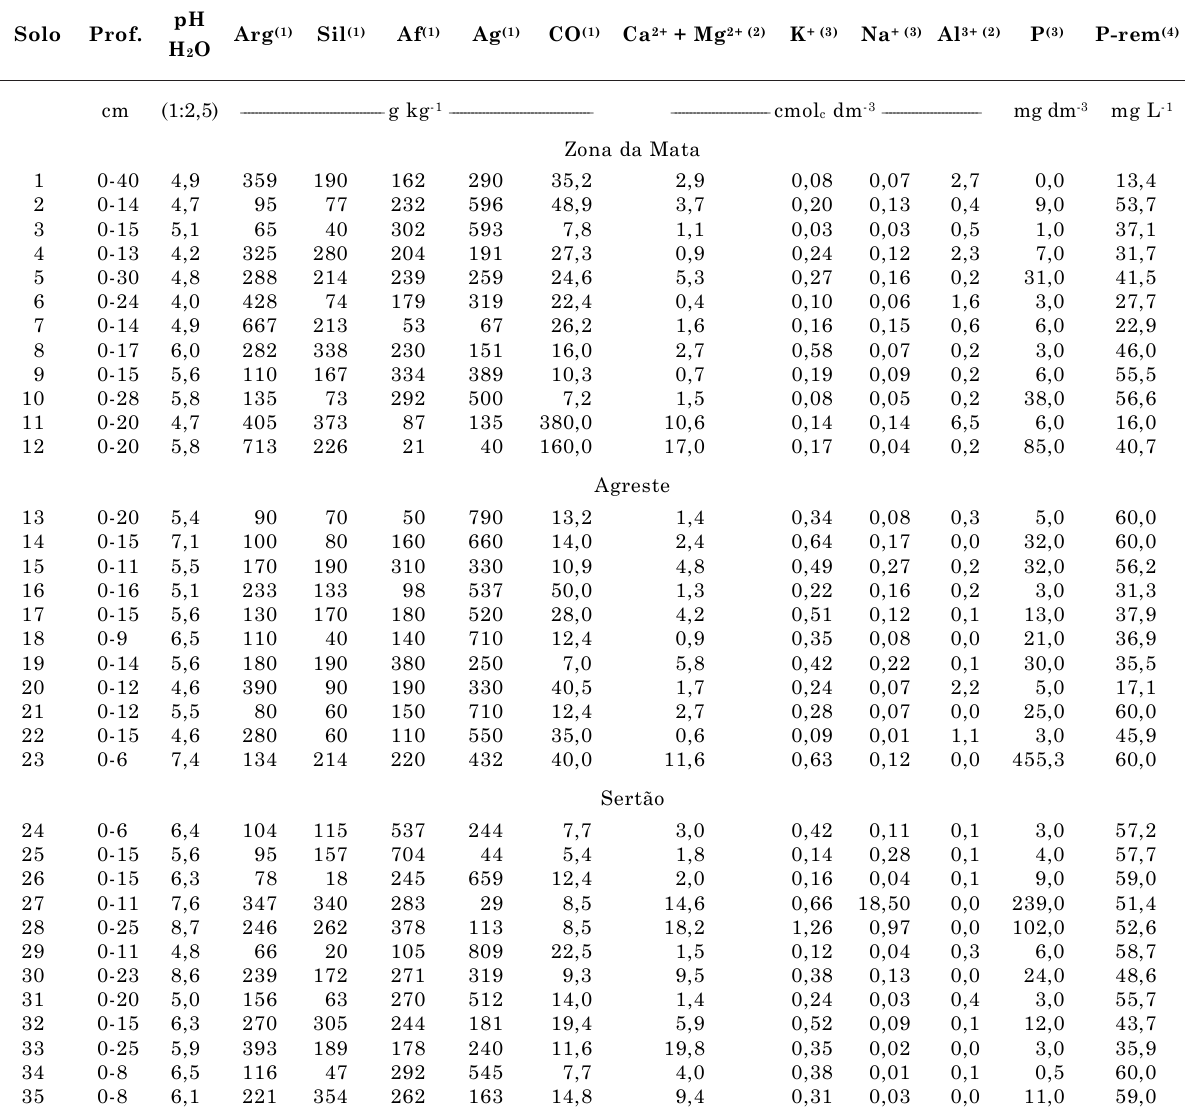
Quadro 2. Características químicas e físicas do horizonte superficial dos Solos de Referência do Estado de Pernambuco